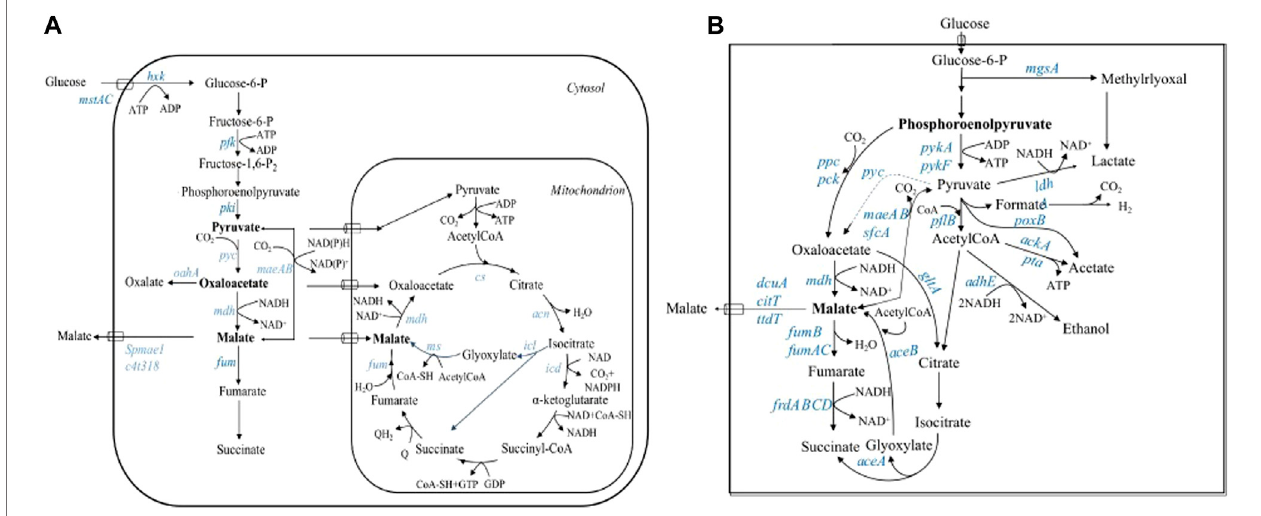
FIGURE1| BiosyntheticpathwaysofL-malicacidineukaryotes (A) andprokaryotes (B) .Thedottedlineindicatesanexogenouspathwaythatdoesnotexistinthe natural strain. Enzyme-coding genes that were manipulated through genetic engineering are depicted in blue. Abbreviation: Panel (A) : acn , aconitase; cs , citrate synthase; c4t318 , malate transporter from Aspergillus oryzae ; frd , fumarate reductase; fum , fumarase; hxk , hexokinase; icd , isocitrate dehydrogenase; icl , isocitrate lyase; maeAB , malic enzyme; mdh , malate dehydrogenase; ms , malate synthetase; mstA/C , monosaccharide transporter; oahA , oxaloacetate acetylhydrolase; pfk , phosphofructokinase; pki , pyruvate kinase; pyc , pyruvate carboxylase; Spmae1 , malate transporter from Schizosaccharomyces pombe. Panel (B) : aceA , isocitrate lyase; aceB , malate synthase; ackA , acetatekinase; adhE , alcohol dehydrogenase; citT , citrate transporter; dcuA , dicarboxylate uptake transporter; frdABCD , fumarate reductase; fumB/fumAC , fumarase; gltA , citrate synthase; ldhA , D-lactate dehydrogenase; mgsA , methylglyoxal synthase; pck , phosphoenolpyruvate carboxykinase; p fl b , pyruvate formate-lyase; poxB , pyruvate oxidase; ppc , phosphoenolpyruvate carboxylase; pta , phosphate acetyltransferase; pyk , pyruvate kinase; sfc , succinate/ fumarate transporter; ttdT , tartrate